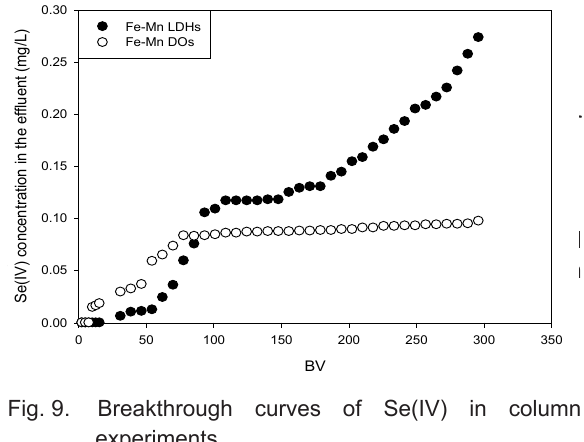
Breakthrough curves of Se(IV) in